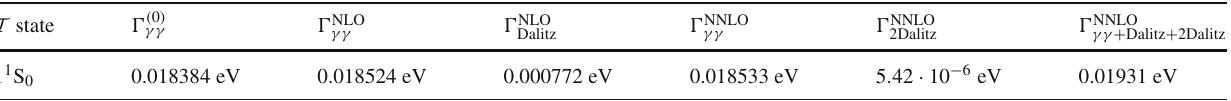
Table 3 Numerical values of the partial para-ditauonium decay widths grouped by individual LO, NLO, and NNLO contributions to its total width. The last column gives the total NNLO para-ditauonium annihilation width